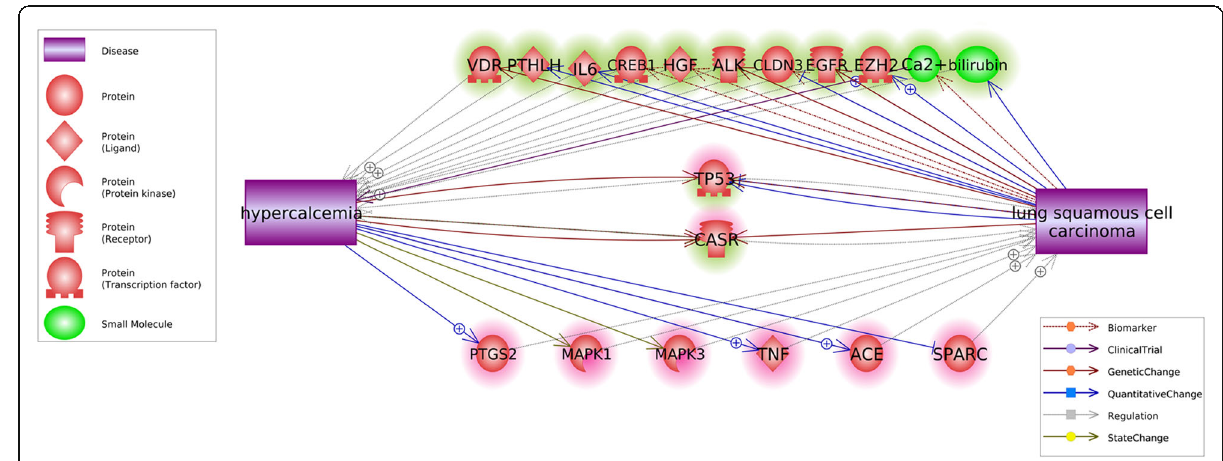
Fig. 3 Interactive network through which hyperkalemia and lung squamous cell carcinoma may influence each